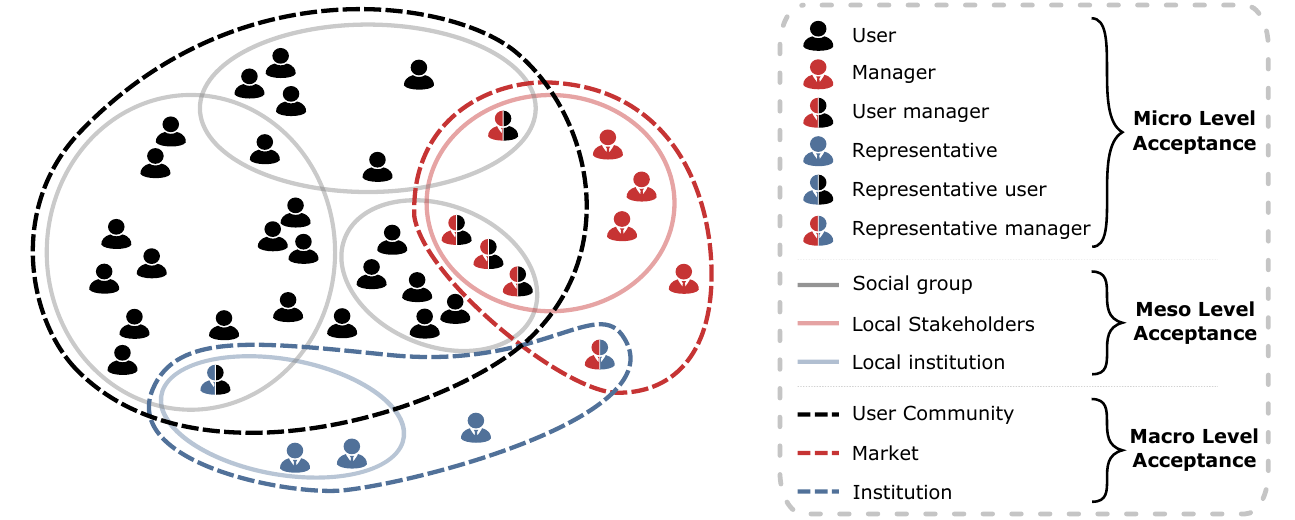
Figure 10. Representation of the different social